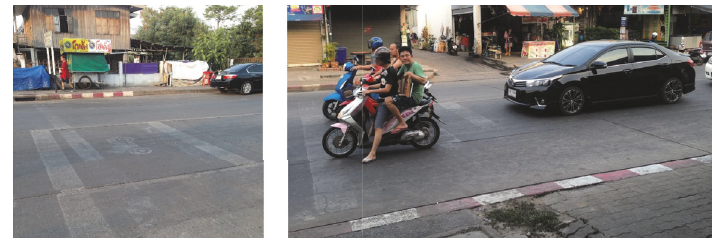
Figure 5: Example of the exclusive zone for motorcycle stopping at a signalized intersection in Thailand.